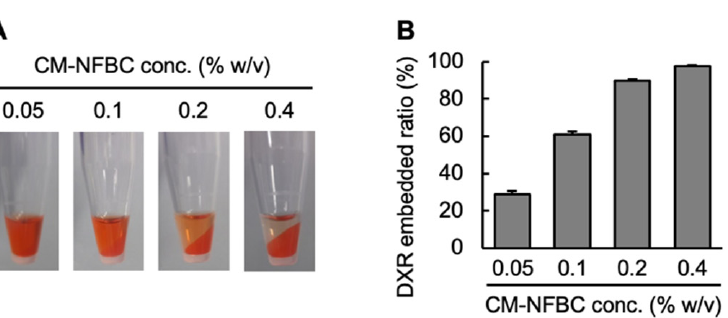
Figure 1. Preparation of DXR-embedding into CM-NFBC (DXR/CM-NFBC). DXR/CM-NFBC was prepared by mixing a DXR solution (2 mg/mL) with an equal volume of different concentrations of CM-NFBC (0.1, 0.2, 0.4, or 0.8% w / v ). The concentration of DXR in the resultant DXR/CM-NFBC was adjusted to 1 mg/mL, and that of CM-NFBC was adjusted to 0.05, 0.1, 0.2, or 0.4% w / v . ( A ) DXR/CM- NFBC prepared with different concentrations of CM-NFBC. Photos were taken after centrifugation (15,000× g , 4 °C, 3 min). ( B ) Percentage of DXR embedded in the CM-NFBC. Data represent the mean ± SD ( n = 6).